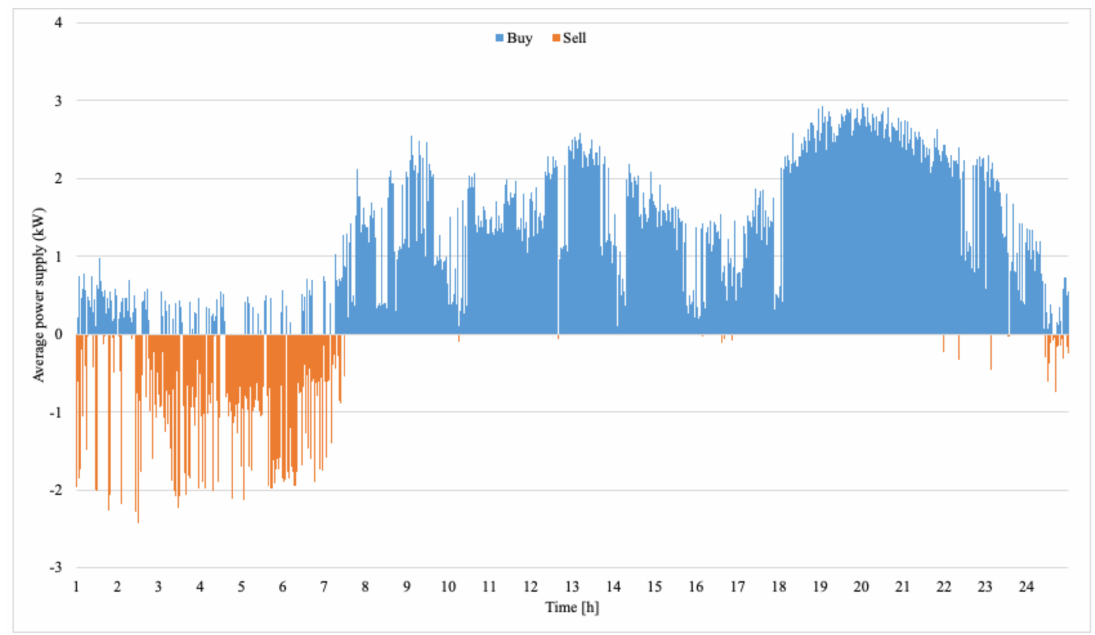
Figure 13. Trading profile of user 5.